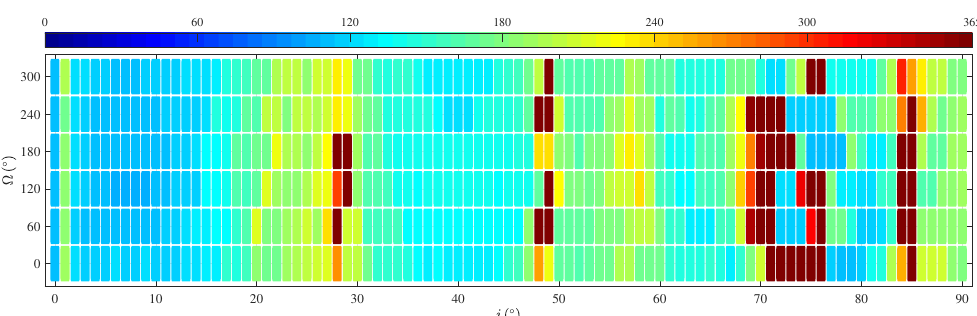
Figure 14. The lifetime counted from the beginning of orbit maintenance to the collision on the surface of the Moon is maintained by thrust (cid:107) T (cid:107) = 20 mN.